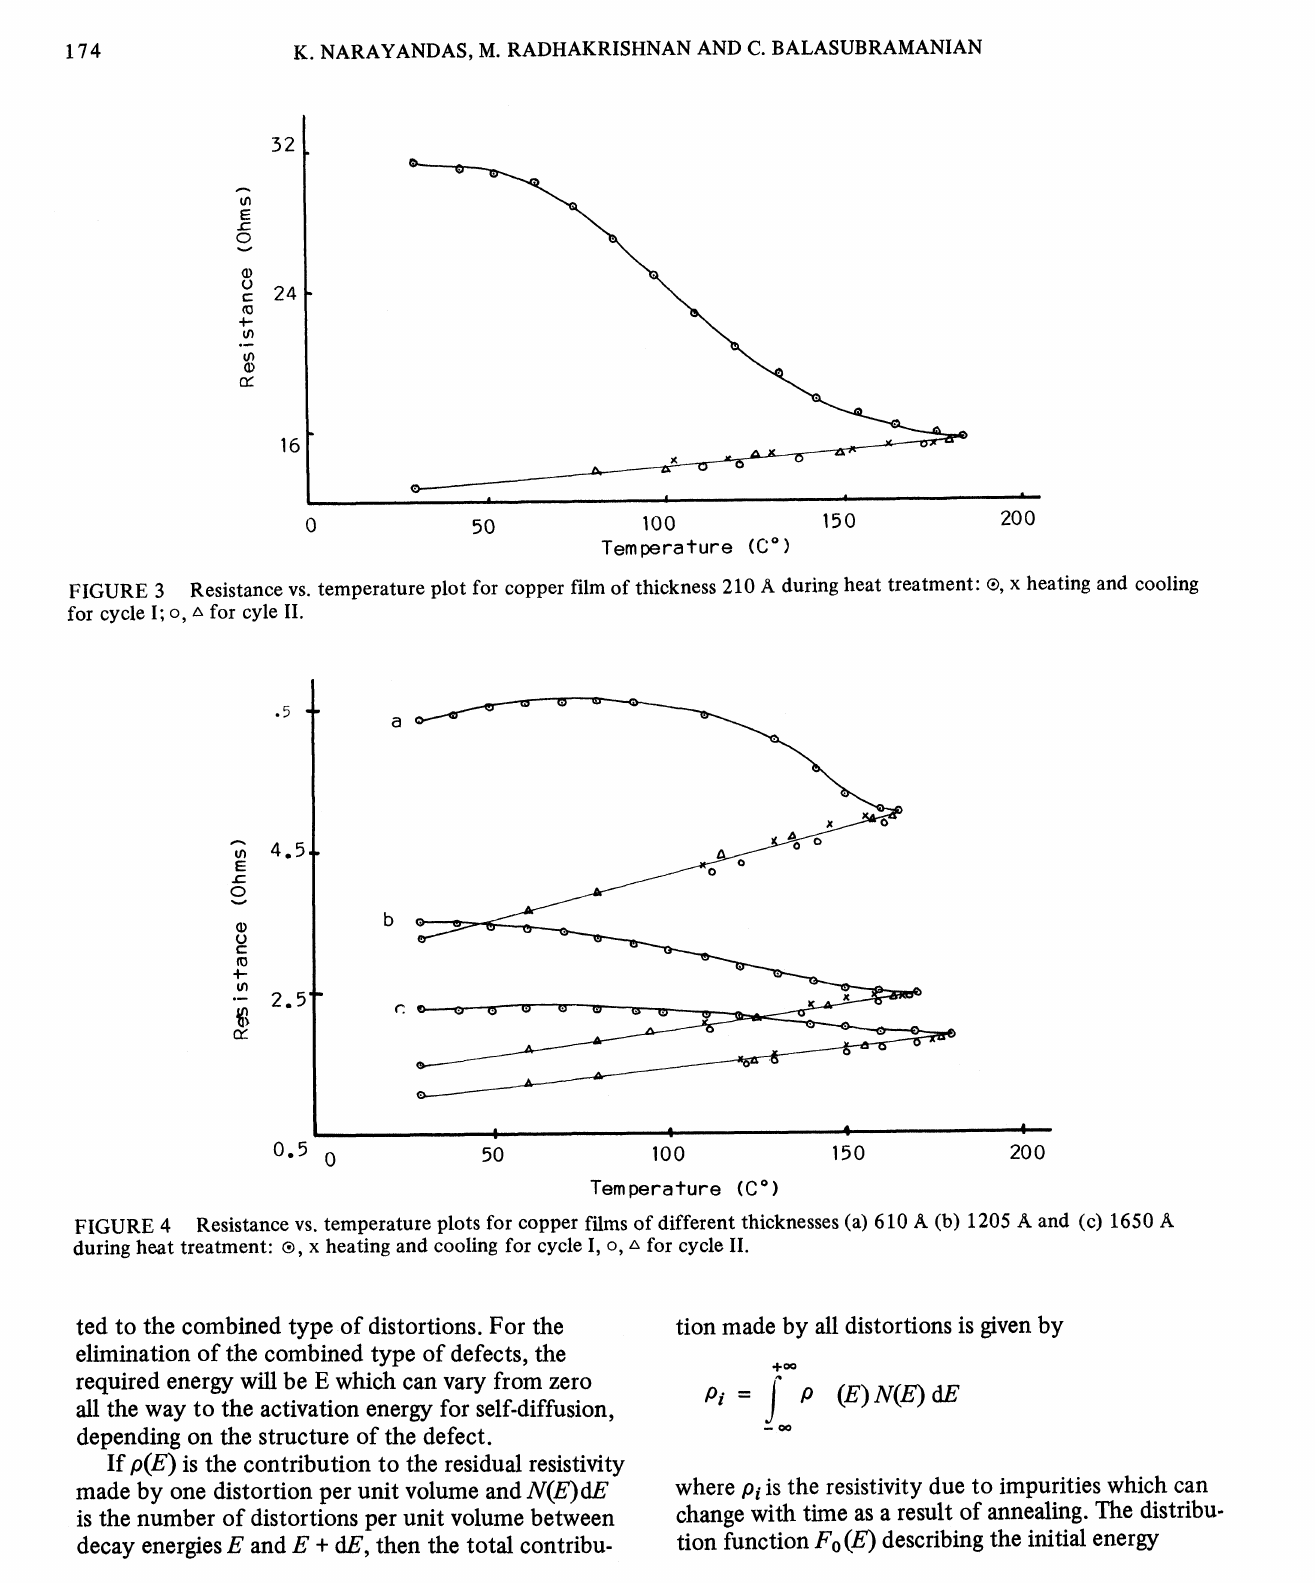
Resistance vs. temperature plots for copper films of different thicknesses (a) 610 A (b) 1205 A and (c) 1650 A during heat treatment: (R), x heating and cooling for cycle I, o, zx for cycle